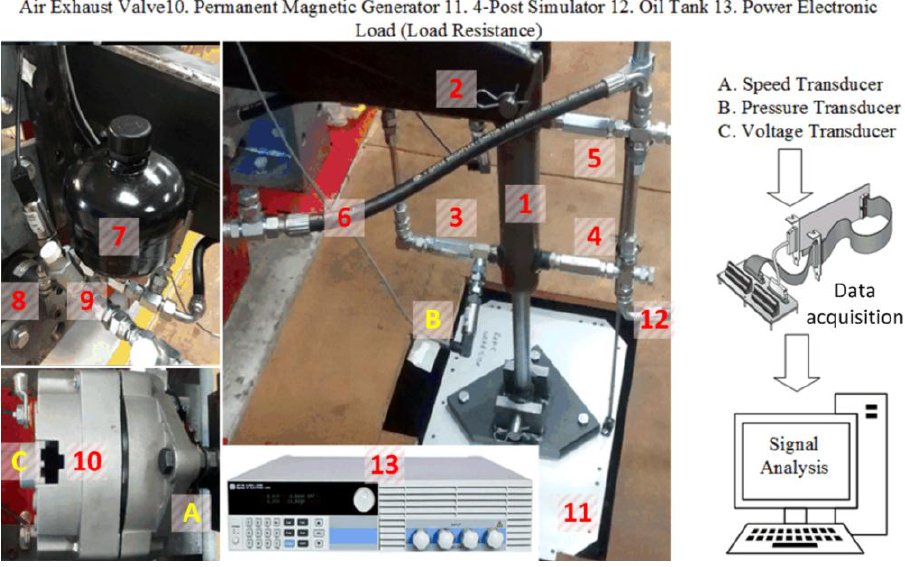
Figure 3. Key components of regenerative shock absorber system.